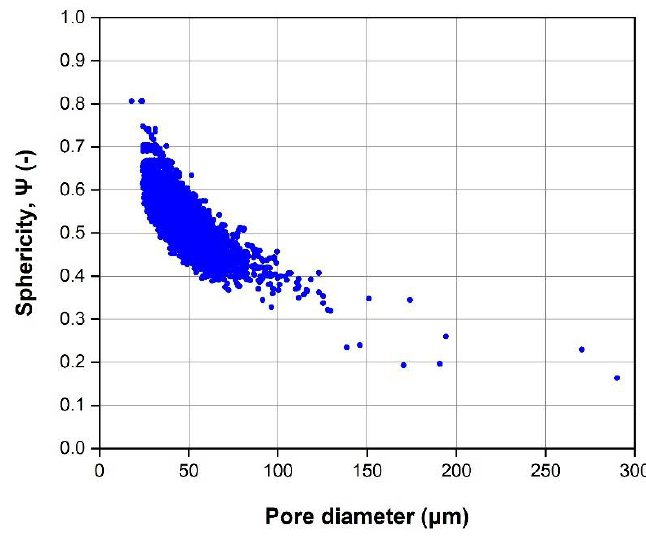
Figure 2. Diameter vs. sphericity of the pores.